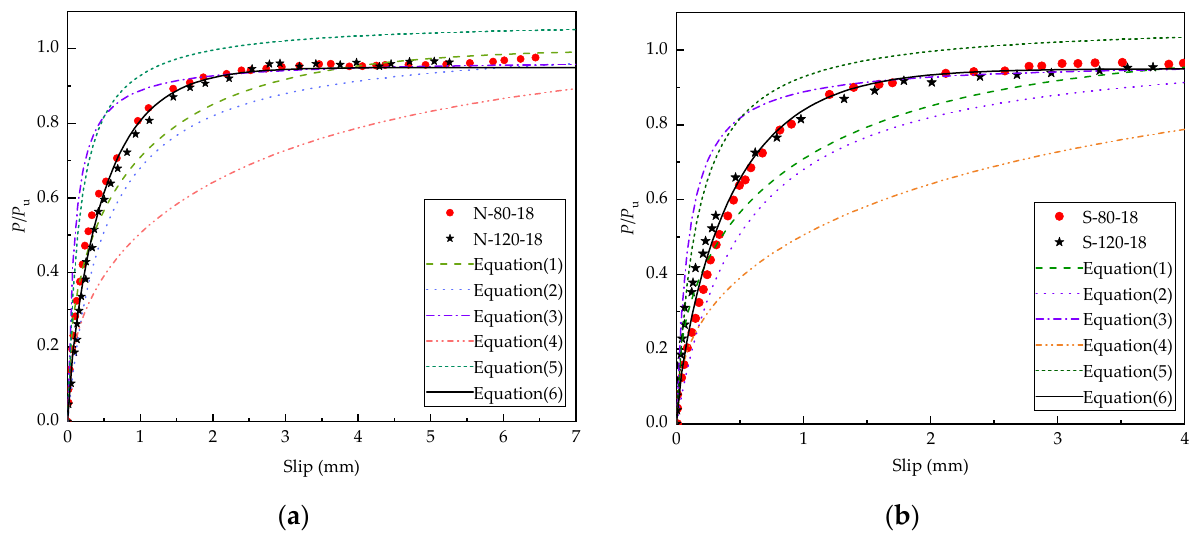
Figure 12. Comparison of push-out test and calculated load-slip curves: ( a ) NC; ( b ) SFRCC.